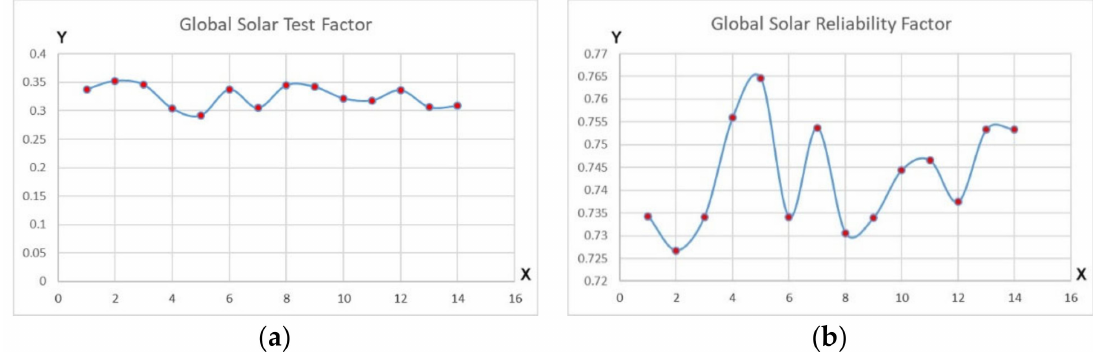
Figure 10. Hybrid testing suite for global test scenarios: ( a ) global STF generated according to the total number of mixed errors and faults; X-axis representing the number of days; Y-axis representing the hybrid STF parameter; ( b ) global SRF generated according to the global STF parameter; X-axis representing the number of days; Y-axis representing the hybrid SRF parameter; adapted from [16].